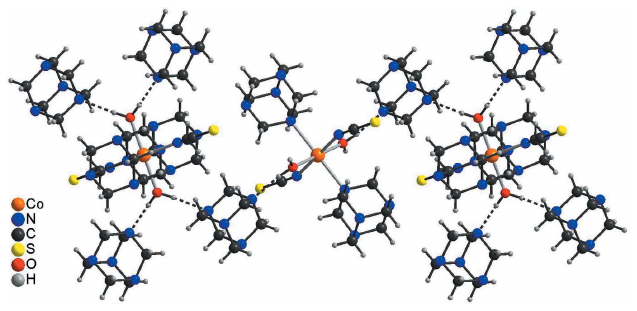
Figure 3 Part of the crystal structure of the title compound showing the connection of discrete complexes by hexamethylenetramine solvate molecules via O—H (cid:2)(cid:2)(cid:2) N hydrogen bonds (dashed lines).